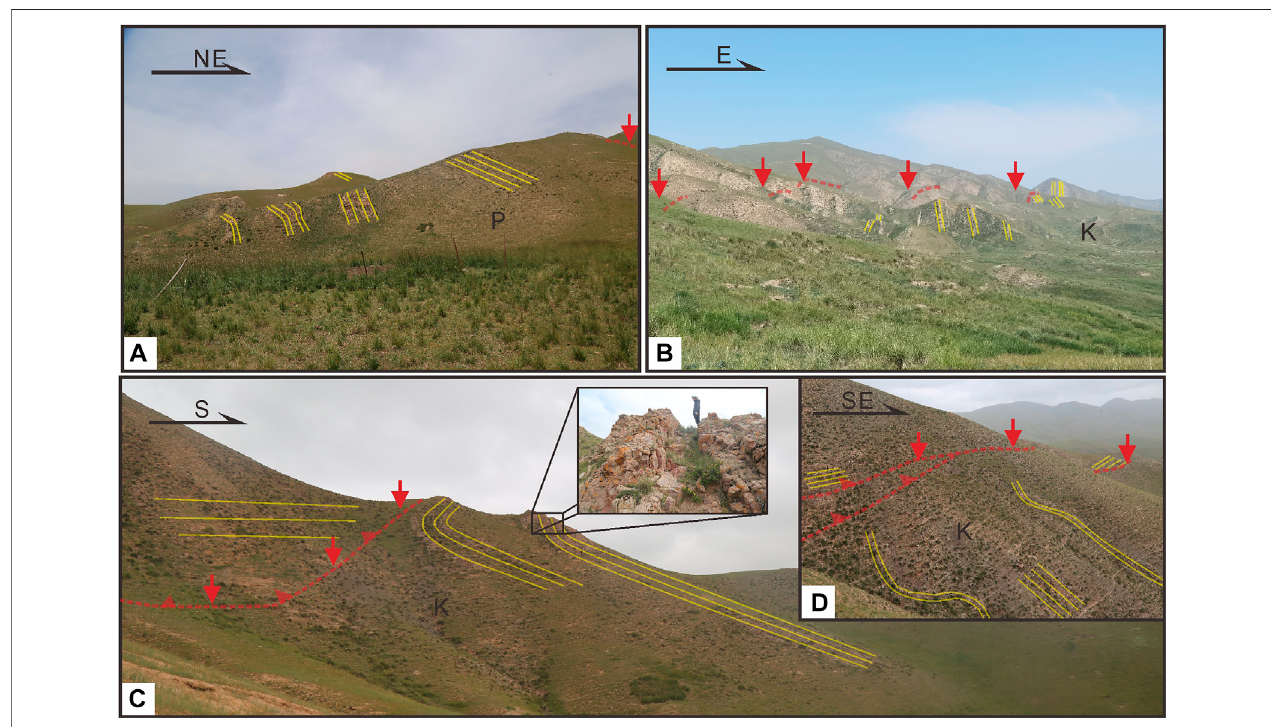
FIGURE 8 | Field photos of the CCT and related deformation. Yellow lines mean bedding. ( Figure 5 for regional location of this map). (A) The CCT, located on the southern GZT, trends NE – SW. The pluton was thrust over the Permian strata and formed a fold topping to the central basin. The upper strata are reversed and become vertical in the middle part of the section. (B) The CCT, located in the western Huangcheng Basin, trends NE – SW and the fault plane is not exposed clearly. The fold toppingtothecentralbasinemergesat theeasternend ofthisfault,andhas aSE-trendingtectonicpolarity thatpointstowardthecenter ofthebasin. (C) TheCCT fault, which is located in the northwestern part of the sedimentary basin in Caicaotai. The fault plane is not exposed clearly, and the footwall strata deformed as a fold topping to the central basin with a SW tectonic polarity. (D) Fault plane located at the northern end of (C) . Here, the footwall deformed to produce a kink fold. the upper strata dip steeply, but become more horizontal in the middle of the section. K: Cretaceous strata. N: Neogene